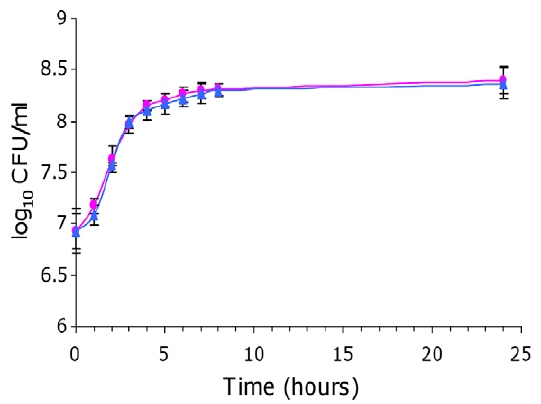
Figure 3. Growth of E.coli strains BEN2908, BEN2908 D fosT and BEN2908 D fosT /pGEM:: fos in the presence of scFOS. Growth curves (OD 450 nm ) of strains BEN2908 (pink circle), BEN2908 D fosT (blue triangle) and BEN2908 D fosT /pGEM:: fos (green square) grown with shaking at 37 u C in M9 minimal medium supplemented with 0.2% scFOS. The average values and standard deviations result from three independent experiments.